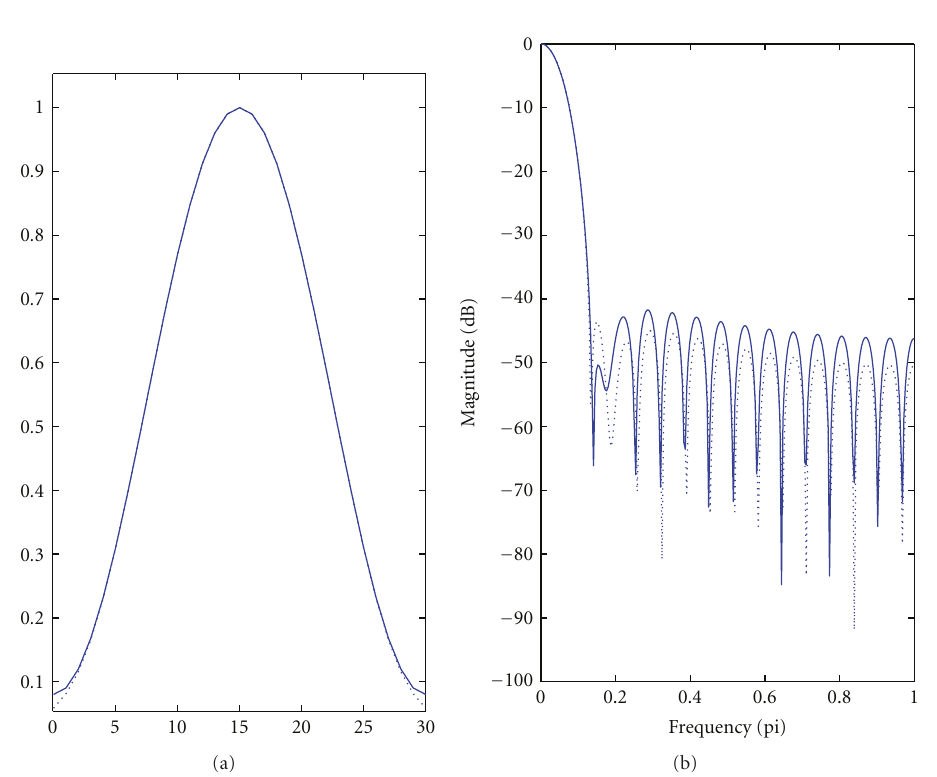
Figure 10: window shape and magnitude response of w ( n ) and Hamming